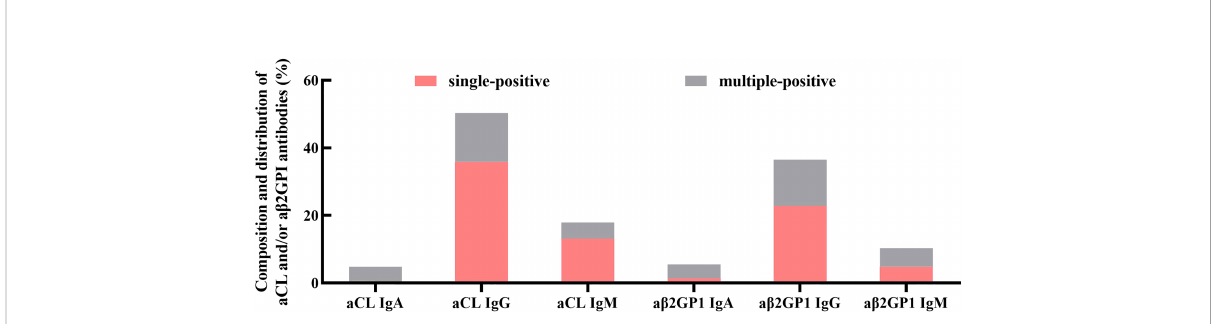
FIGURE 2 Composition and distribution of aCL and/or a b 2GPI antibodies (aPL). The most frequent antibody class was IgG, followed by IgM. The least prevalent antibody class was IgA. Additionally, multiple antibody-positive women accounted for 22.07% of all aPL-positive